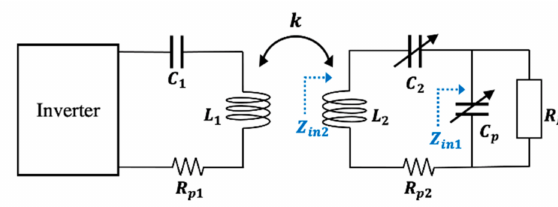
Figure 4. Schematic of the proposed WPT system.